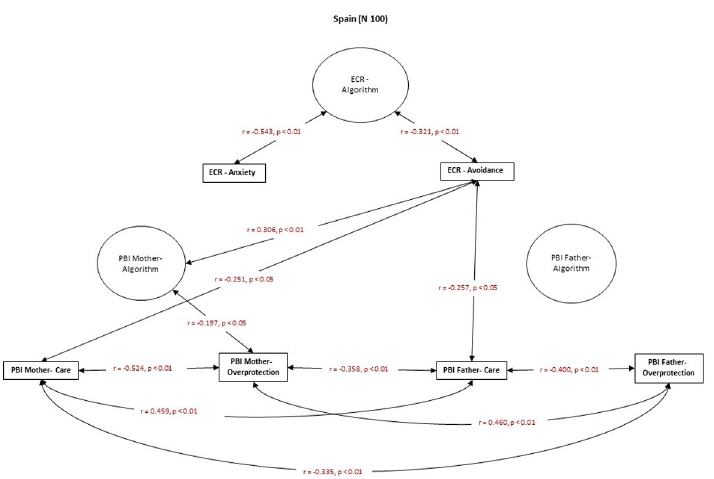
Fig 5. Spearman’s r correlations between ECR and PBI in the Spanish